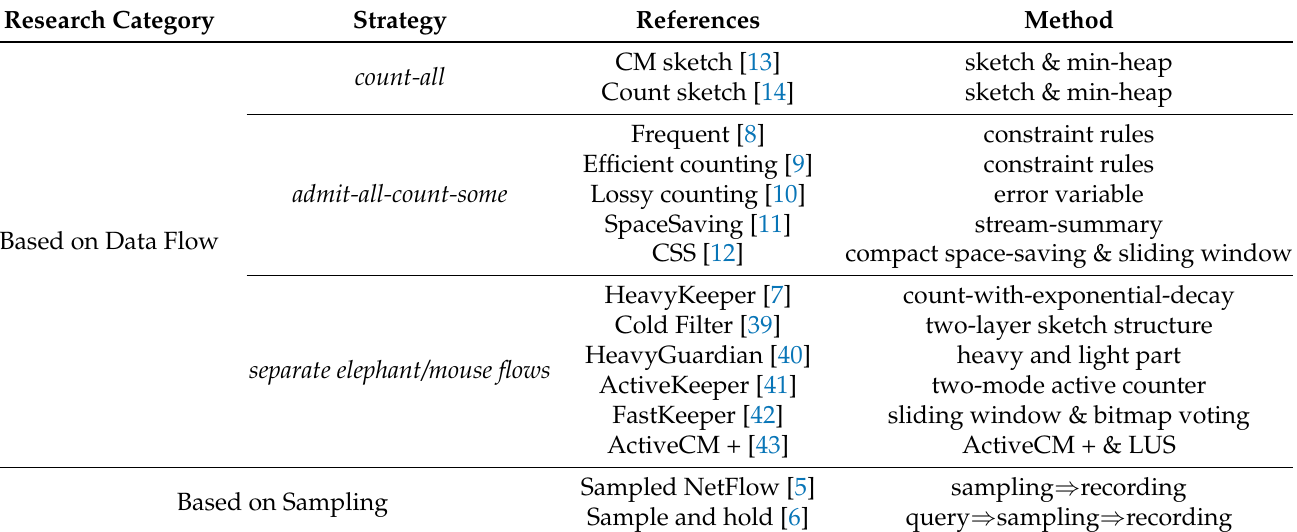
Table 1. Research on top- k elephant flow identification